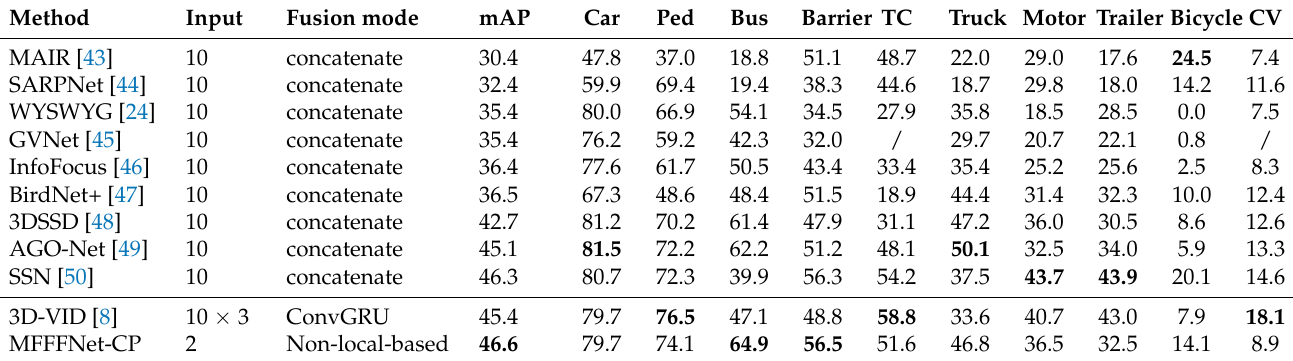
Table 4. Comparison between different methods on the NuScenes